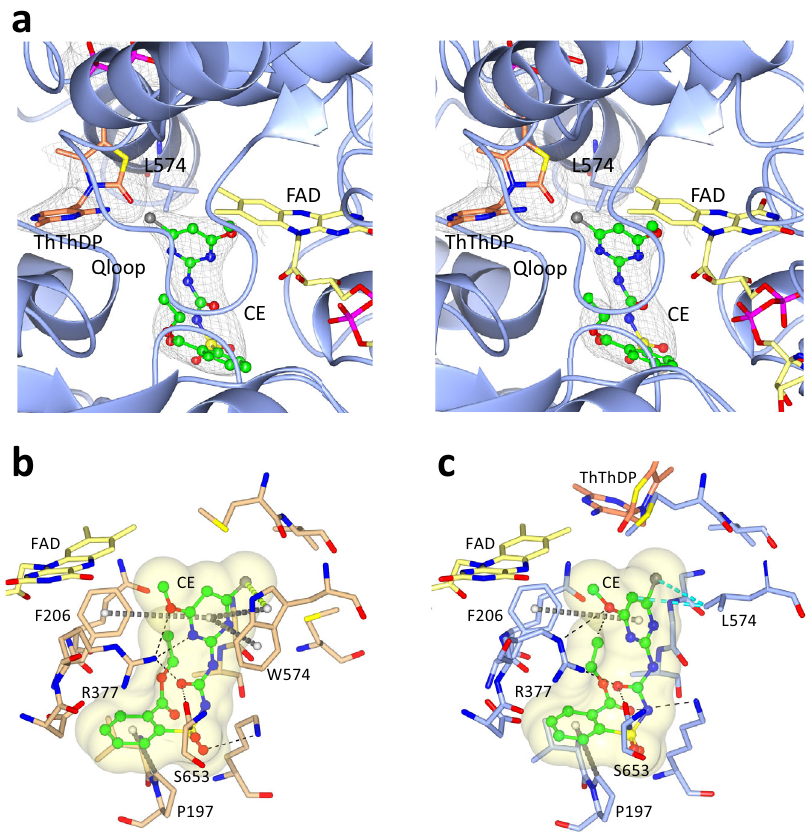
Fig. 3 Binding mode of CE in WT At AHAS and in the W574L mutant. a Stereoview of the CE binding site in W574L. ThDP has been oxidized to thiamine thiazolone diphosphate (ThThDP, light brown). Electron densities (2F o -F c map) in light brown correspond to CE, ThThDP and L574 contoured at 1, 2, and 1 σ , respectively. b Interactions between CE and WT At AHAS (PDB code: 1YBH 38 ). In this structure, ThDP is almost completely degraded and therefore not observed in the density map. c Interactions between CE and the W574L mutant. (All panels) CE is green and in ball and stick representation. FAD is yellow. Dashed lines represent hydrogen bonds (black). The grey dashed cylinders represent π – π and carbon – π interactions. The lime dashed cylinders represent halogen – π interactions. The cyan dashed cylinders represent hydrophobic interactions. Q-loop is a loop in the active site that includes residues 193 to 210. ThThDP thiamine thiazolone